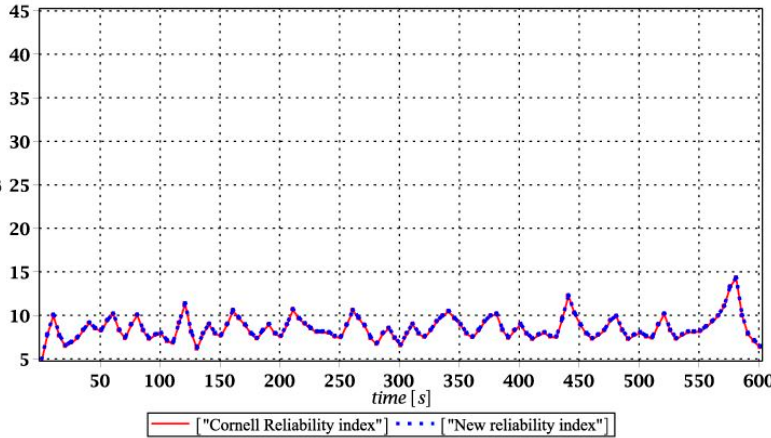
Figure 8. The comparison of dynamic reliability indices for uncertain thickness.